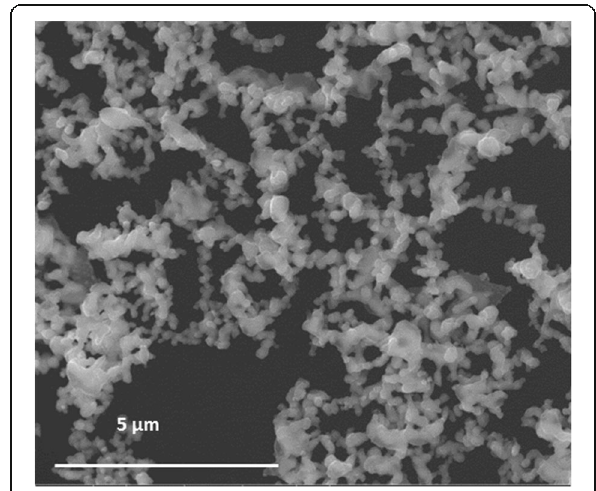
Fig. 2 SEM micrograph of the residual TGA product (palladium powder)